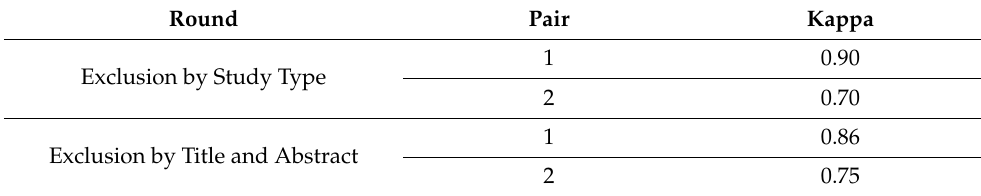
Table 5. Kappa scores for inclusion and